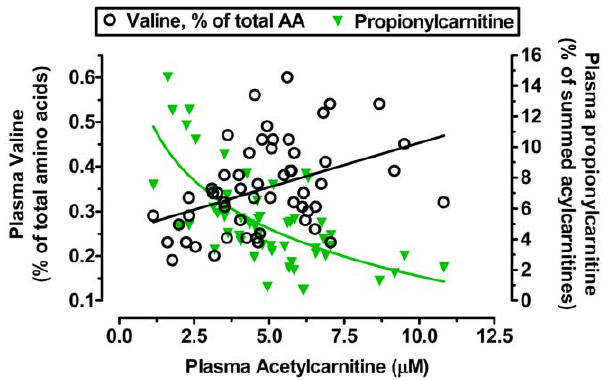
Figure 3. Relative plasma concentrations of propionylcarnitine (green symbols) were reduced concurrent with increases in the relative plasma concentrations of a precursor, valine, with increasing plasma acetylcarnitine concentration in obese African-American women. Symbols represent individuals included in metabolomics studies described in the text.